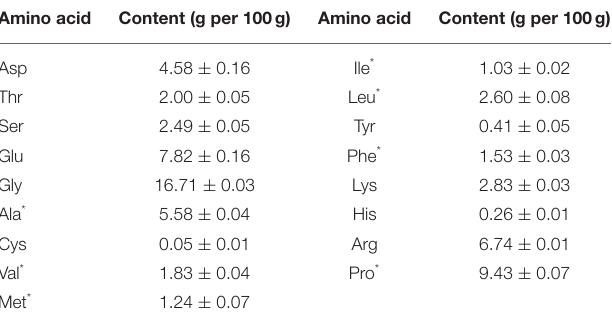
TABLE 1 | Amino acid composition of fish scale gelatin hydrolysate.